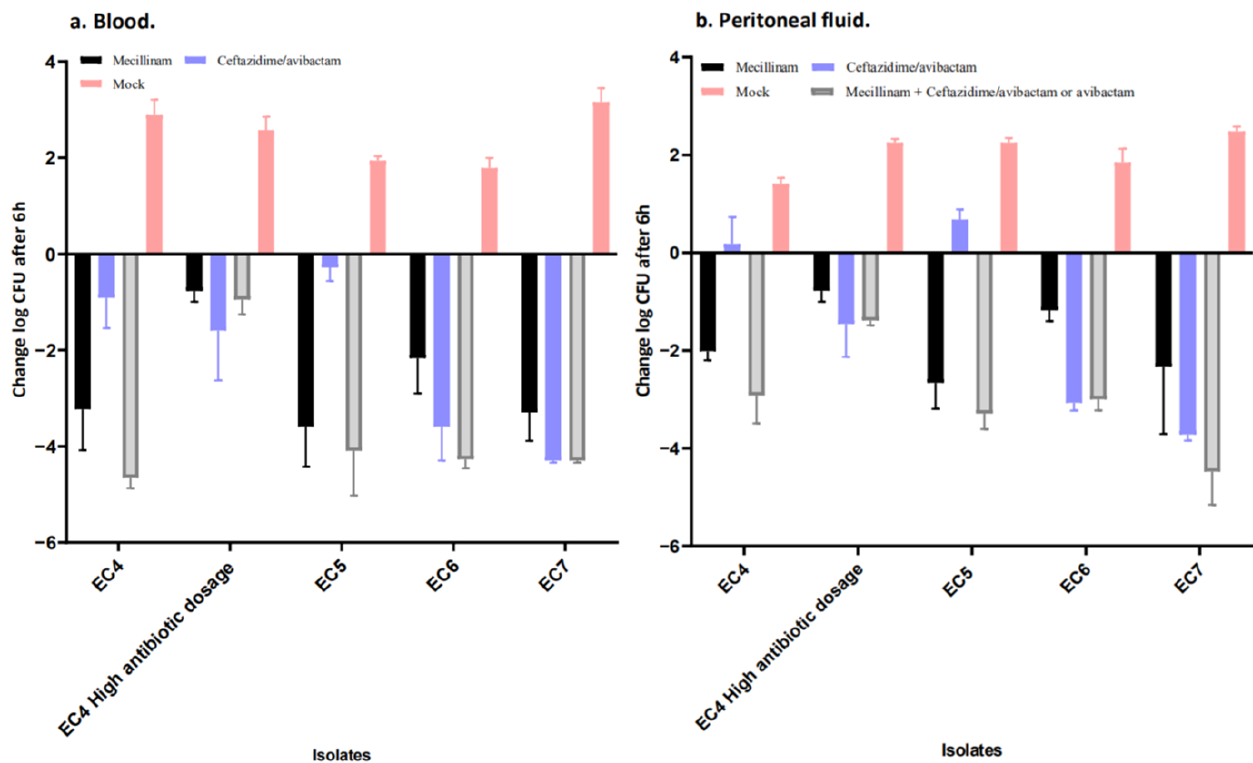
Figure 1. ( a , b ). In vivo results of treatment regimens for the included E. coli isolates. The standard doses were 100 mg kg −1 ceftazidime/avibactam alone, 50 mg kg −1 mecillinam alone, 100 mg kg −1 ceftazidime/avibactam and 50 mg kg −1 mecillinam together or saline administered s.c. at t = 1 h and t = 3 h. For strain EC4, a higher dose was also used, i.e., 200 mg kg −1 ceftazidime/avibactam alone, 200 mg kg −1 mecillinam alone, 200 mg kg −1 ceftazidime/avibactam and 200 mg kg −1 mecillinam together or saline administered at t = 1 h, t = 2 h, t = 3 h and t = 4 h, indicated as “High antibiotic dosage”. Data are presented as changes in log CFU mL −1 in either blood or peritoneal fluid at t = 5 h. The figure compares CFU counts in peritoneal fluid and blood at the end of antibiotic treatment to mock-treated controls at the same time points. Thus, the figure compares all CFU counts at the end of the treatment period with animals sacrificed at 0 h, i.e., immediately before antibiotic treatment was initiated. The result of this new depiction is that reductions in CFU counts caused by antibiotic treatment appeared smaller as the difference was calculated relative to controls at baseline with lower counts instead of compared to 5 h mock-treated controls. The “mock” group depicted the increase in bacterial burden in mock-treated animals during the treatment period.